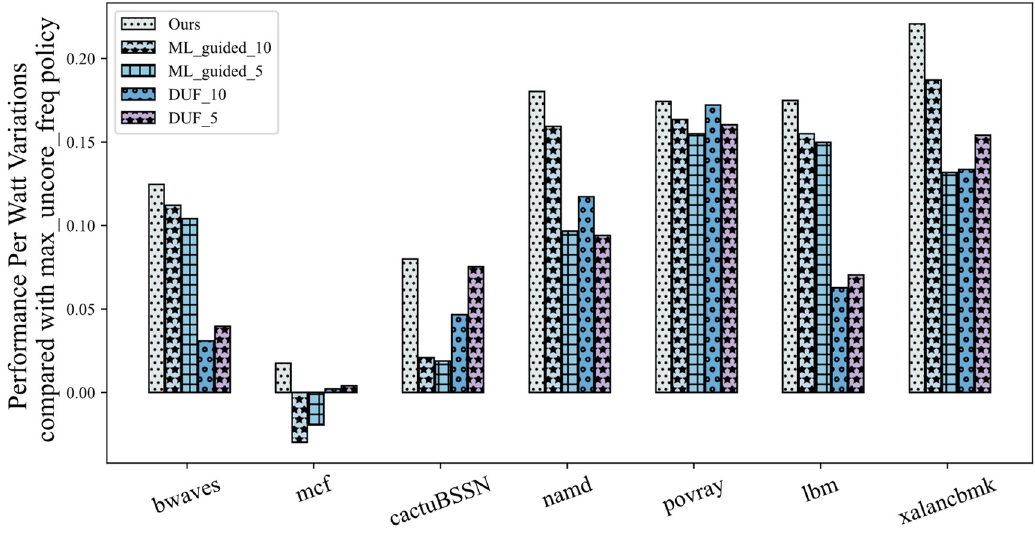
Figure 4. PPW variations of different models under different benchmark apps.